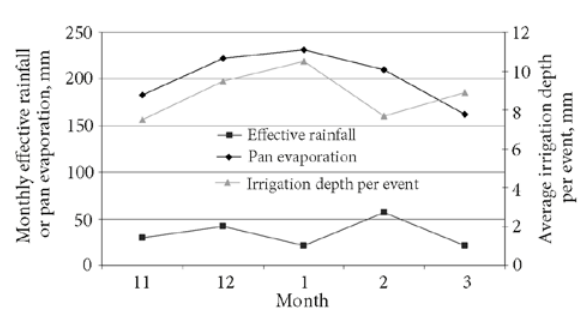
Fig. 4. Variation of the average pan evaporation, effective rainfall and irrigation depth values with month during the trial